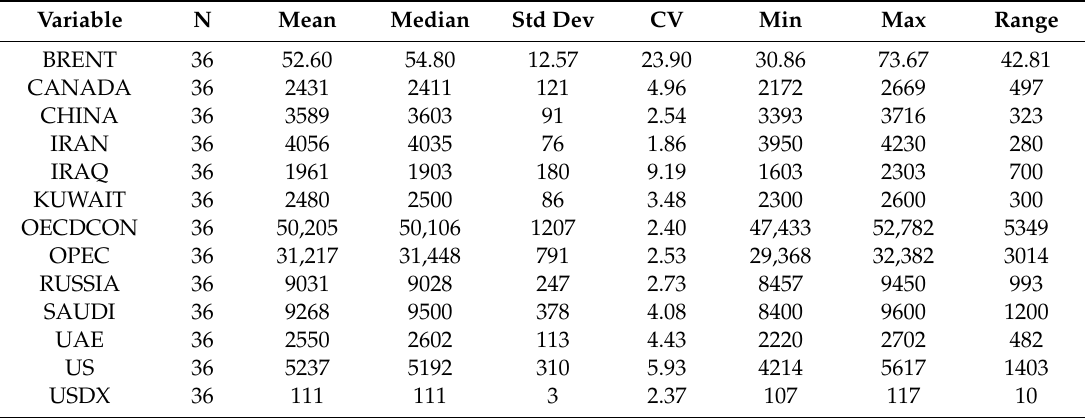
Table 9. Panel 3 period (2004–2006): summary statistics.